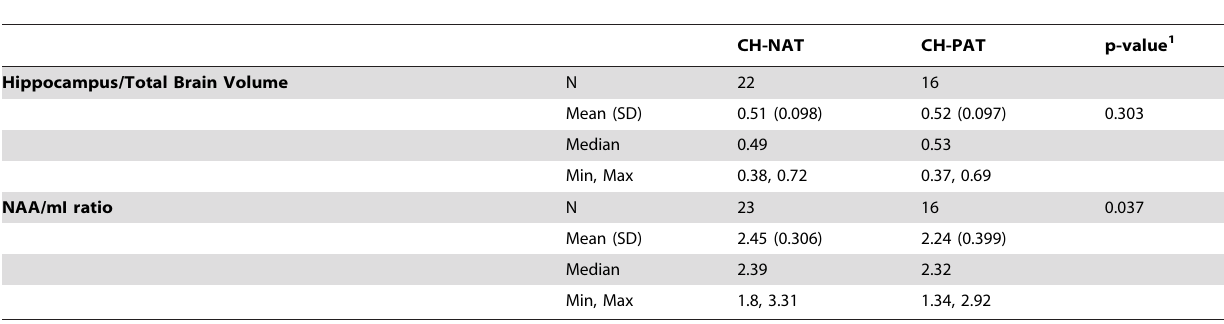
Table 8. Quantitative volumetric MR imaging and